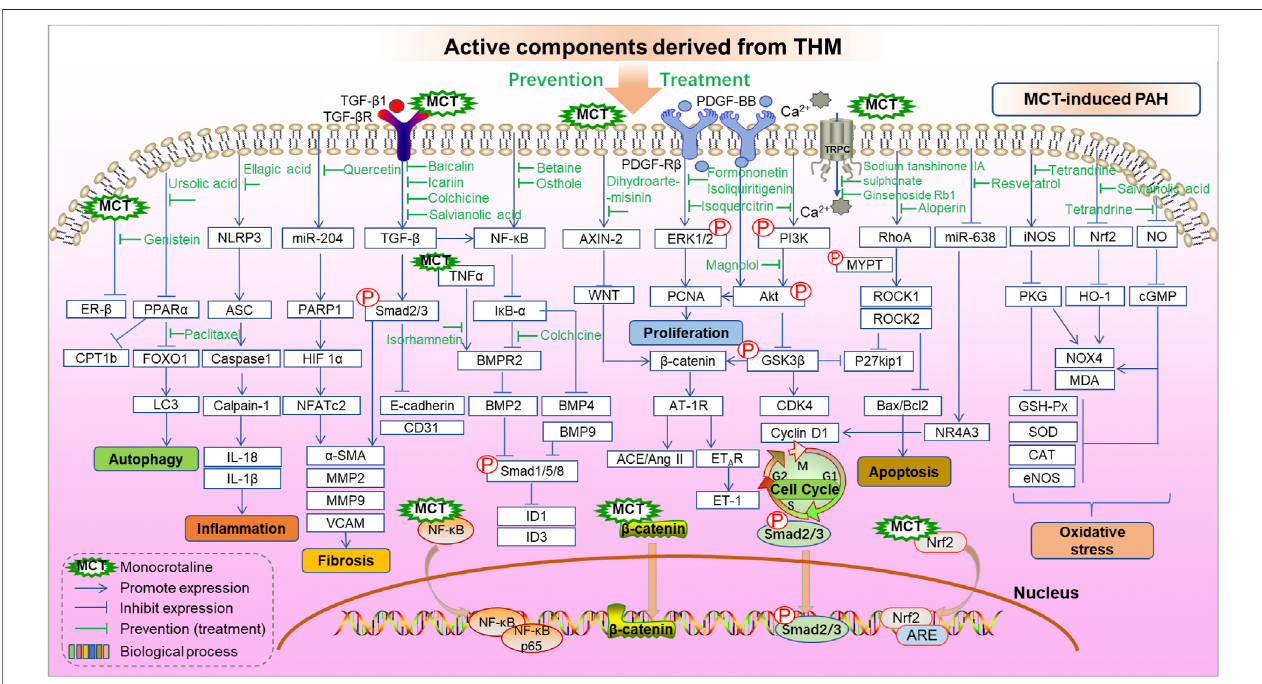
FIGURE 4 | Role and mechanisms of frequently studied active components derived from THM in treating MCT-induced PAH.